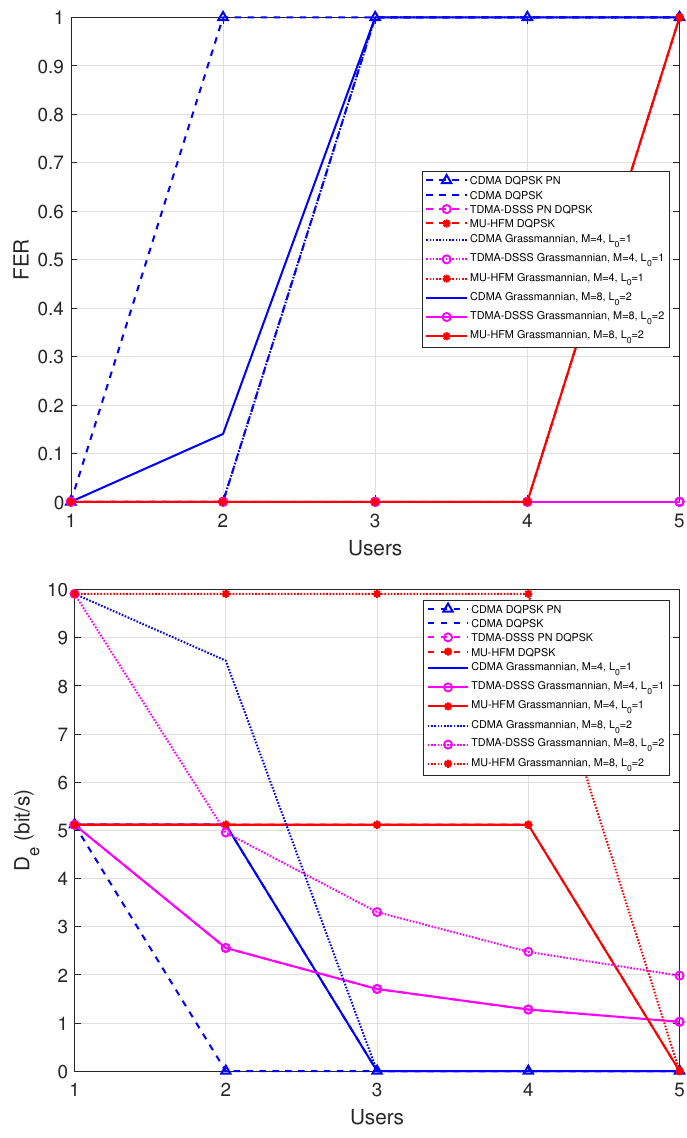
Figure 7. AverageFER performance (up) and effective data rate per user (down) versus the number of users for the replayed channel of the roadstead of Brest, where N r = 5 sensors, and average SNR = 10 dB. The abbreviation PN means that a PN code type preamble was used; in the other cases, a MU-HFM type preamble was